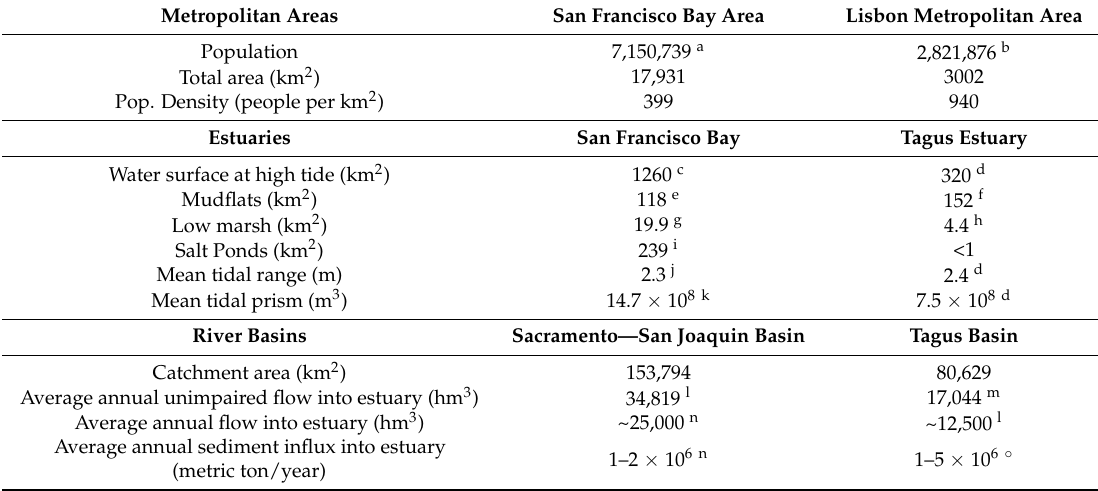
Table 1. Statistics for the SF Bay and Tagus